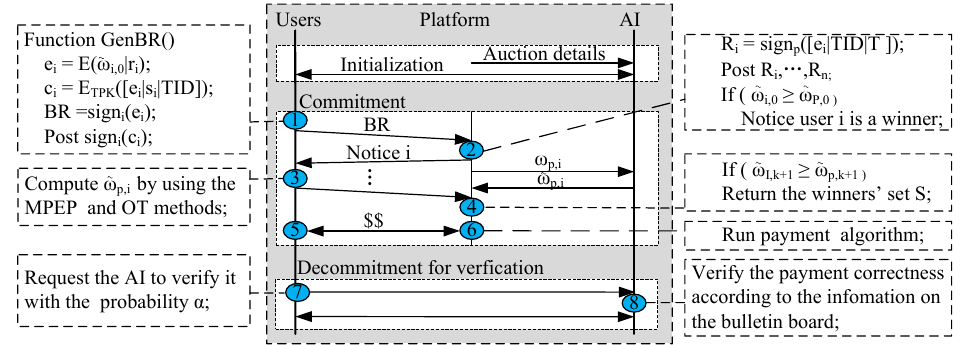
Figure 4. Our privacy-preserving verifiable framework for submodular